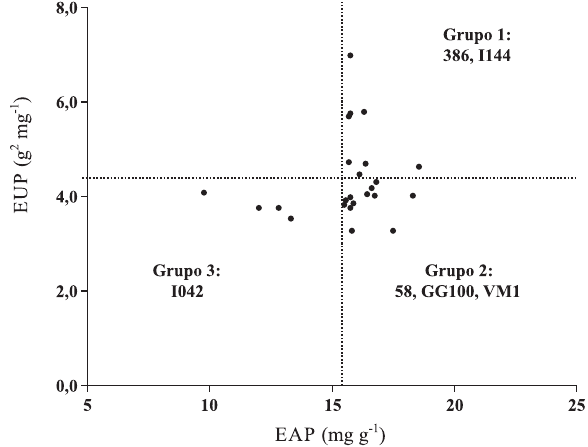
Figura 3. Diagrama de distribuição dos clones de eucalipto em função das eficiências de absorção (EA) e de utilização (EU) de